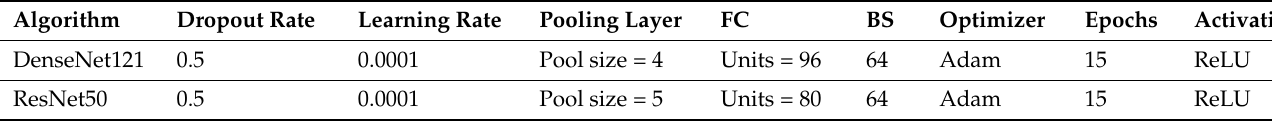
Table 3. Parameters used for DenseNet121 and ResNet50.